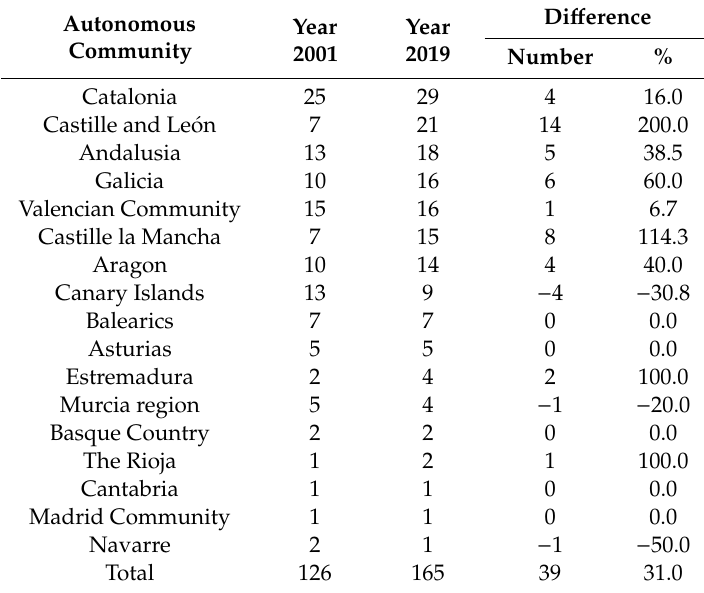
Table 2. Number of mineral water bottling plants in Spanish autonomous communities for the years 2001 and 2019. Source: [39] European Commission: List of Mineral Waters Recognized by Member States (consultation on 8 February 2019).